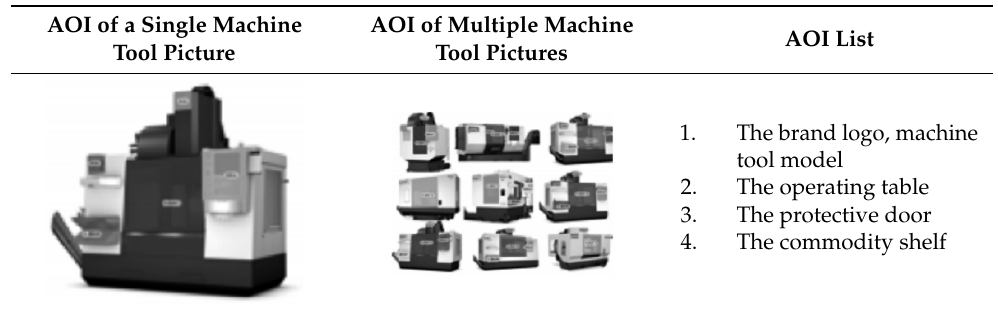
Table 2. Illustration of the machine tool picture AOI.